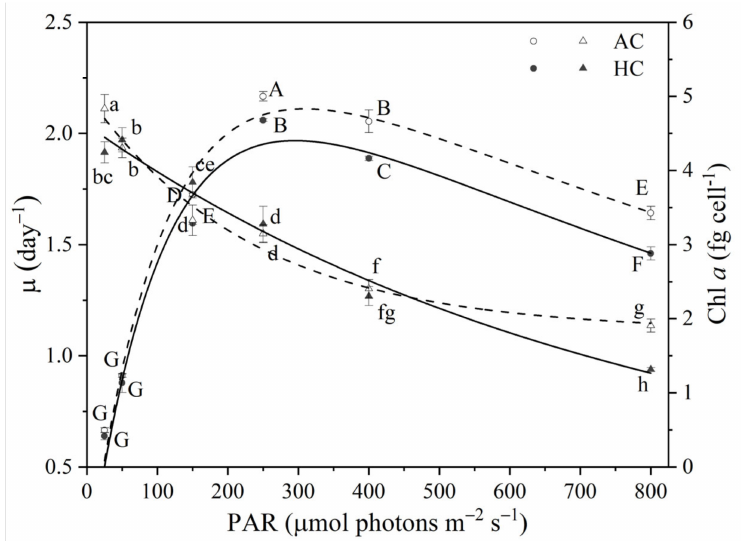
Figure 1. Specific growth rate ( µ ) (circles) and chlorophyll a content (triangles) of Synechococcus CB0101 grown under different light levels combined with the ambient (AC, 415 µ atm, the dotted line) or elevated p CO 2 (HC, 1000 µ atm, the solid line). The values are means ± SD of triplicate cultures. Different letters (uppercase for µ , lowercase for Chl a ) indicate significant ( p < 0.05) differences among the